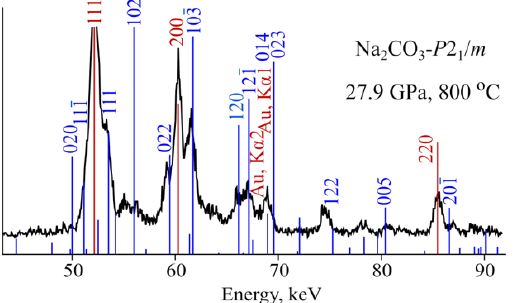
Figure 3. Indexing of experimental diffraction pattern recorded at 27.9 GPa with P 2 1 / m structure of Na 2 CO 3 .